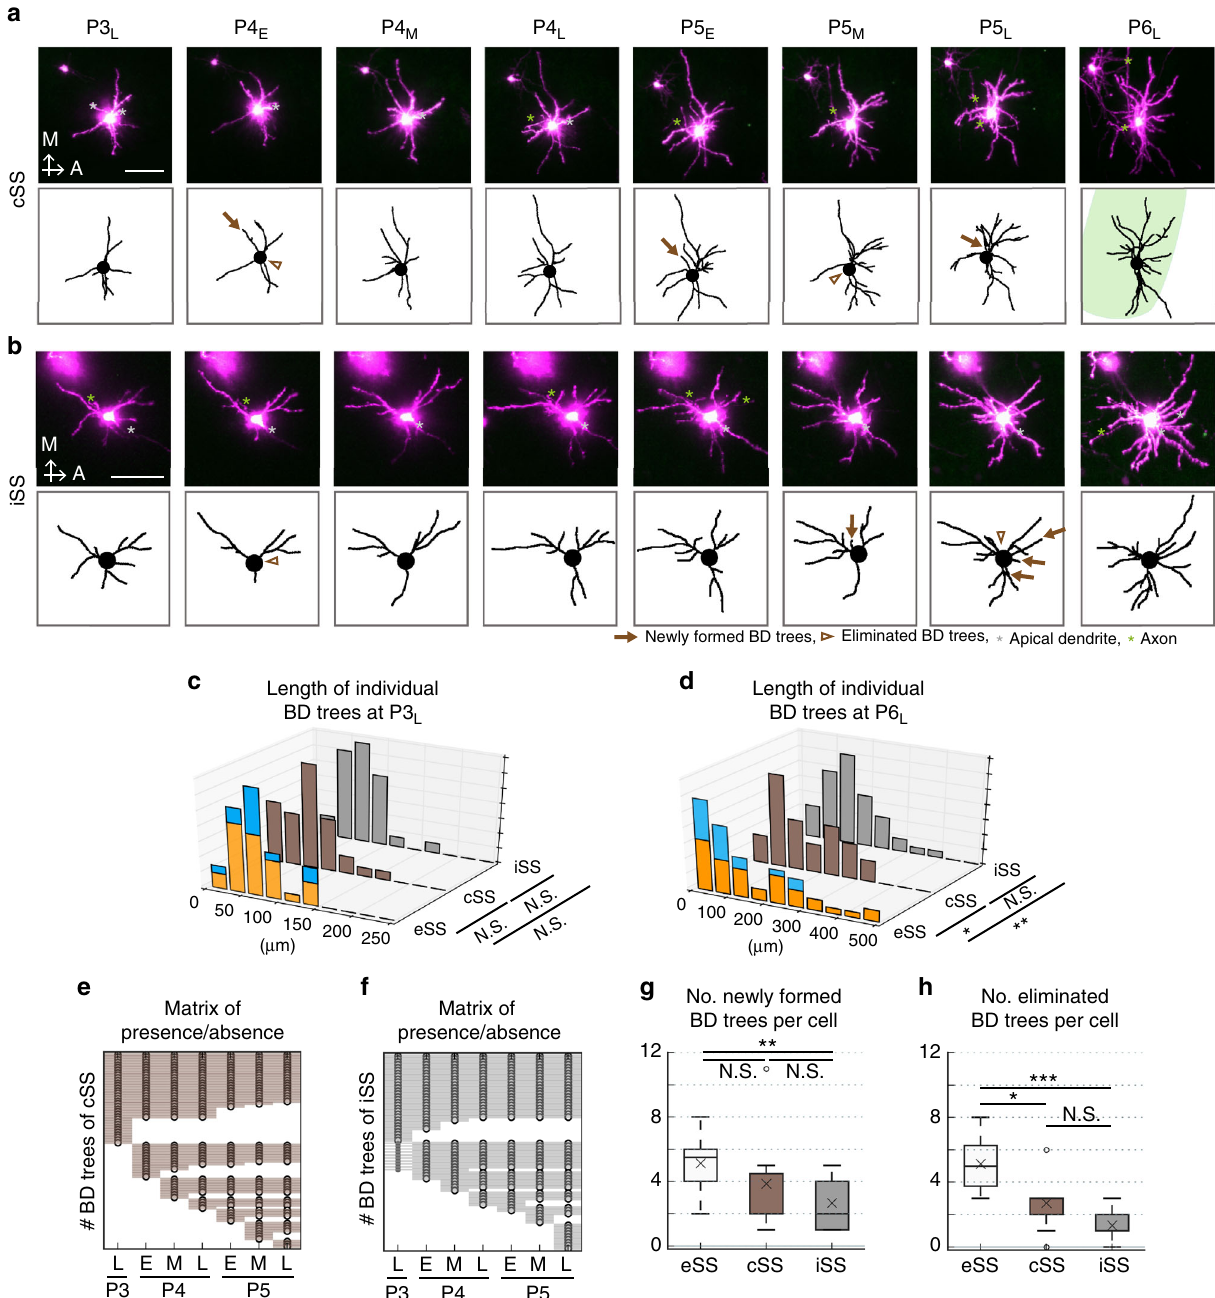
Fig. 5 BD tree dynamics in the absence of spatial bias of TCA inputs. a , b (Top) Z-stack images of a representative barrel-center SS (cSS) neuron ( a ) and ION-cut mouse SS (iSS) neuron ( b ). Gray asterisk, AD; green asterisk, axon. (Bottom) BD morphologies of the neuron shown in the upper panel. Arrows, newly formed BD trees; arrowheads, origin positions of eliminated trees. Scale bars: 50 µ m. c , d Histograms of length of individual BD trees of eSS (40 trees, 8 neurons, 4 mice; mean ± SD = 64.98 ± 36.10 μ m), cSS (35, 7, 2; 60.81 ± 36.35) neurons and iSS (30, 7, 2; 62.92 ± 32.78) neurons at P3 L ( c ) and eSS (54 trees, 8 neurons, 4 mice; 145.37 ± 125.26 μ m), cSS (43, 7, 2; 152.68 ± 92.53) and iSS (47, 9, 3; 137.82 ± 78.24) neurons at P6 L ( d ). Orange: inner BD trees. Blue: outer BD trees. At P3 L (eSS vs. cSS: p = 0.480, F = 1.014; eSS vs. iSS: p = 0.595, F = 1.213; cSS vs. iSS: p = 0.860, F = 1.230, F -test with Holm ’ s correction). At P6 L (eSS vs. cSS: p = 0.044, F = 1.832; eSS vs. iSS: p = 0.002, F = 2.563; cSS vs. iSS: p = 0.134, F = 1.399, F -test with Holm ’ s correction). See also Supplementary Fig. 5i, j. e , f Matrix of presence/absence of individual trees of 7 cSS (2 mice) ( e ) and 9 iSS neurons (3 mice) ( f ). g Number per cell of BD trees that were newly formed between P4 E and P5 L in eSS (8 neurons, 2 mice), cSS (7, 2) and iSS neurons (9, 3). eSS vs. cSS: p = 0.310, r = 0.403; eSS vs. iSS: p = 0.008, r = 0.873, cSS vs. iSS: p = 0.464, r = 0.188, Brunner – Munzel test with Holm ’ s correction. h Number per cell of BD trees that were eliminated between P3 L and P5 L in eSS, cSS and iSS neurons. (eSS vs. cSS: p = 0.022, r = 0.793; eSS vs. iSS: p < 0.001, r = 4.430; cSS vs. iSS: p = 0.129, r = 0.417, Brunner – Munzel test with Holm ’ s correction). Box plot interpretation is described in the